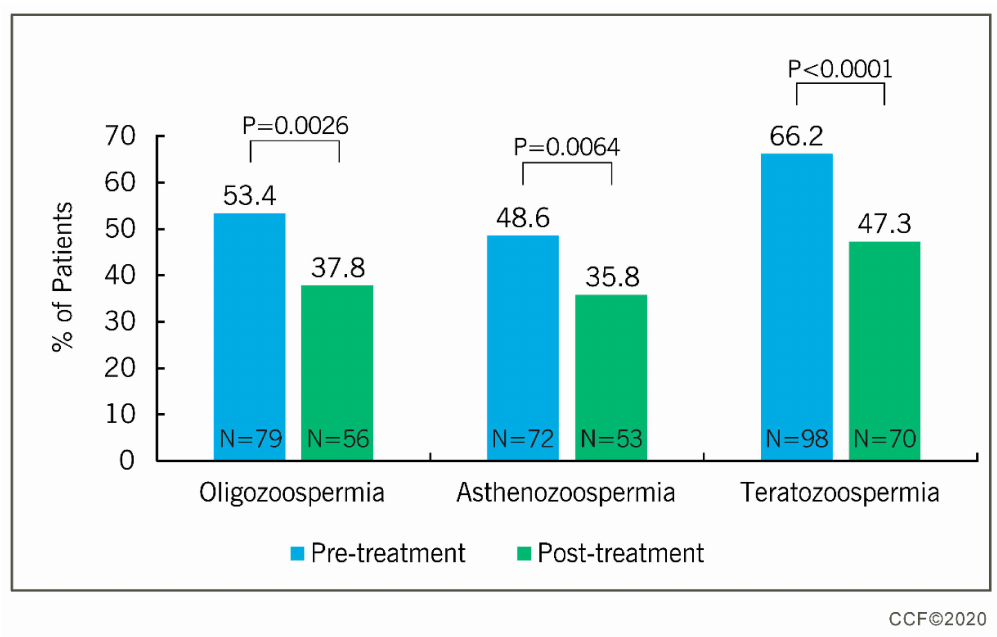
Figure 2. Outcome of FH PRO treatment on infertile men ( n = 119) with oligozoospermia (sperm concentration < 15 × 10 6 / mL), asthenozoospermia (total motility < 40%), and teratozoospermia (normal sperm morphology < 4%). McNeamar test was used to calculate the percent